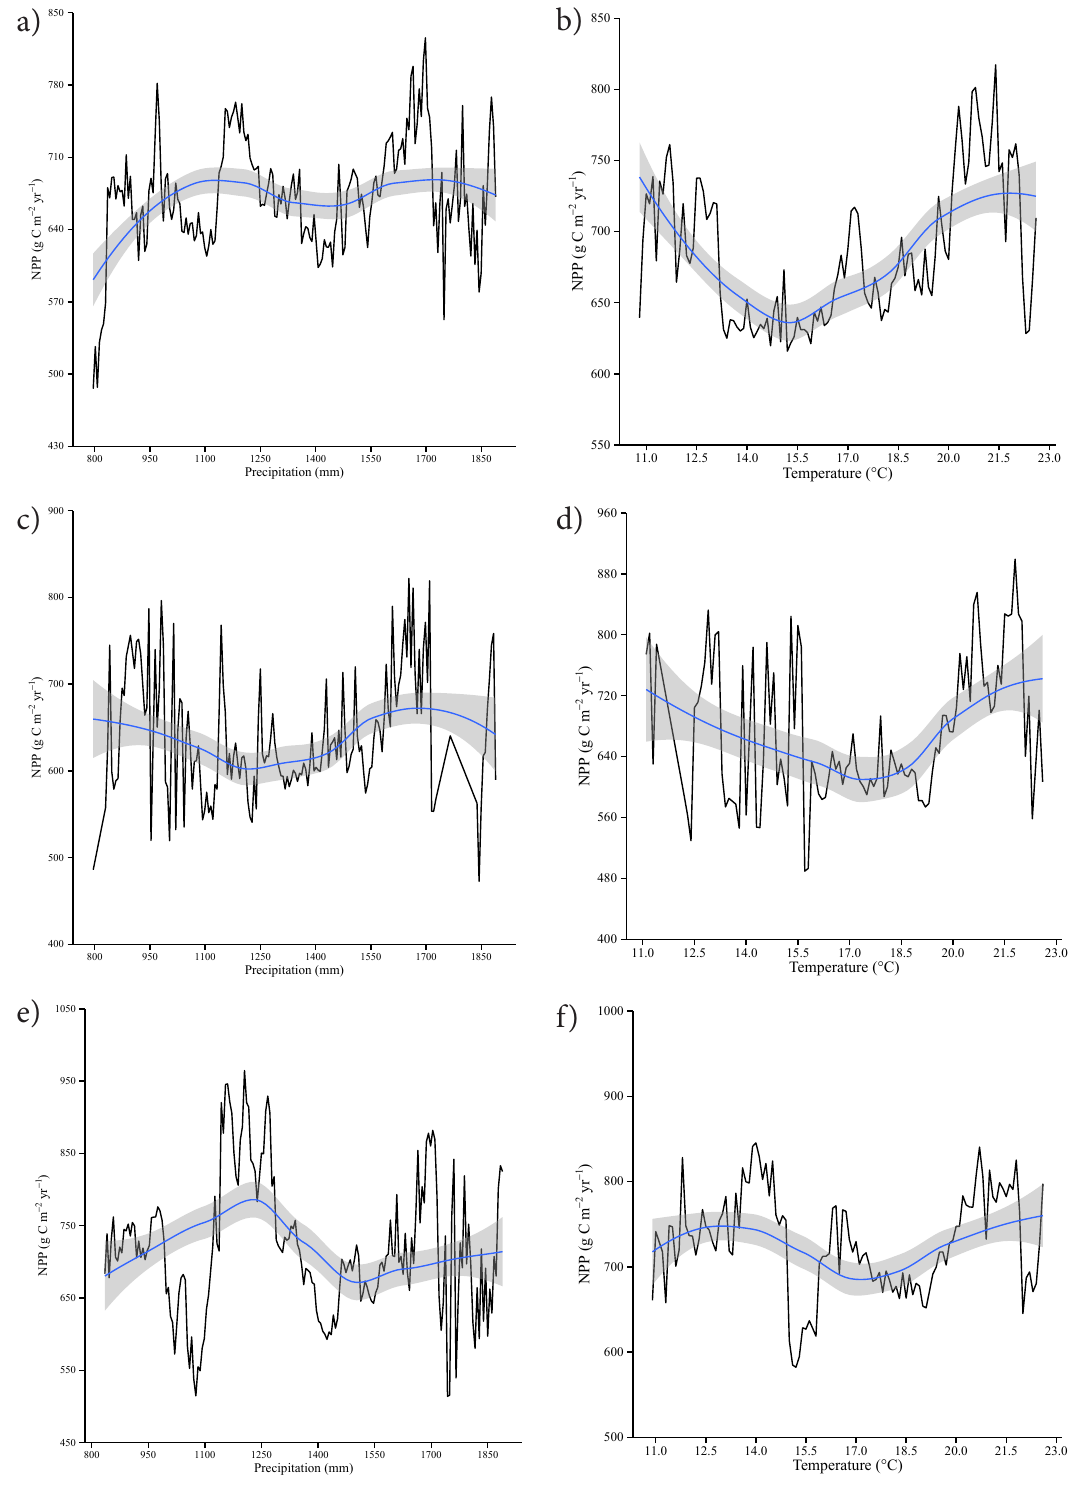
Figure 10. Zonal analysis of the NPP pattern of (a) coniferous forest with precipitation; (b) coniferous forest with temperature; (c) Chinese fir with precipitation; (d) Chinese fir with temperature; (e) broad-leaved forest with precipitation; (f) broad-leaved forest with temperature. Thin lines connect points representing the average NPP against precipitation or temperature. Bold lines represent conditional